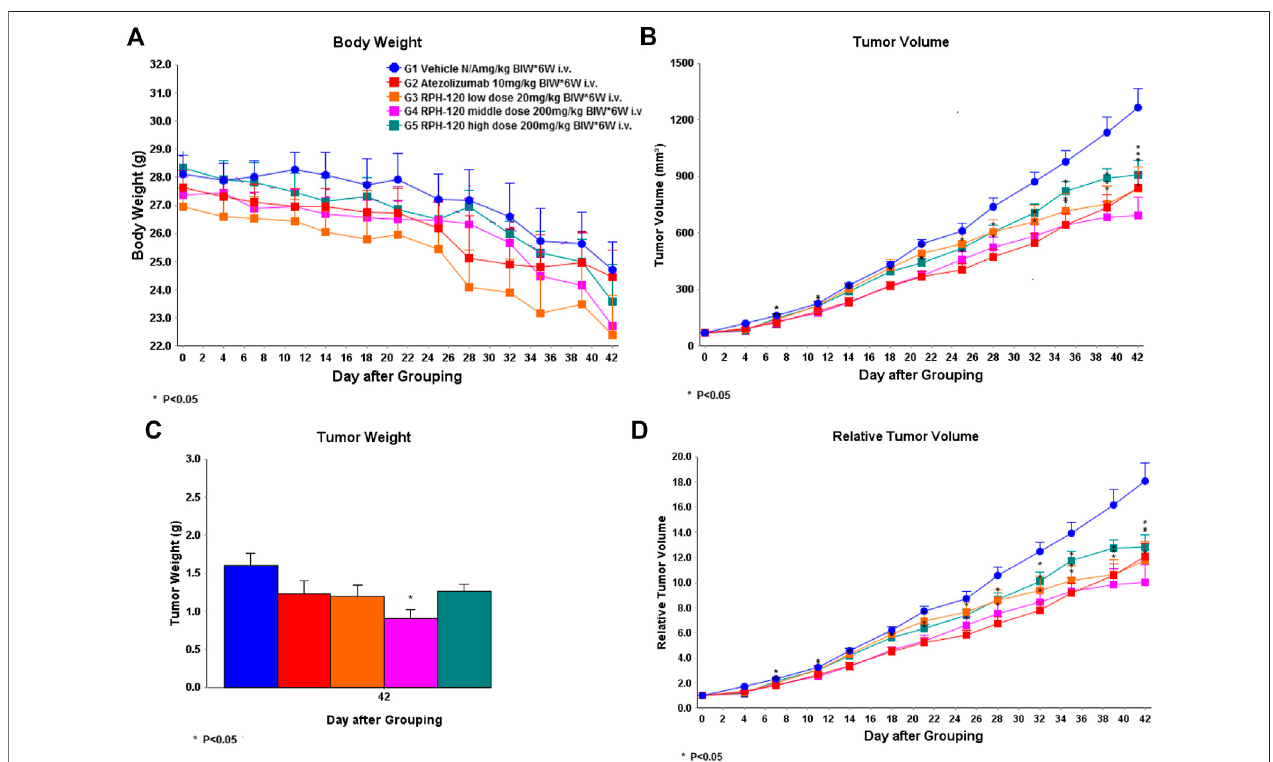
FIGURE 5 | The effect of RPH-120 on growth of human lung adenocarcinoma HCC-827 subcutaneous xenografts in CD34 + humanized Mice. Panel A - Body Weight in the indicated mouse groups; Panel B - Tumor Volume (V) in the indicated mouse groups. It was calculated as follows: V (cid:1) V (cid:1) (length × width2) / 2. Panel C - Tumor Weight was measured on Day 42. Panel D - Relative tumor volume (RTV) was calculated as follows: RTV (cid:1) V t /V 0 , where V t was the volume on each day, and V 0 was the volume at the beginning of the treatment.